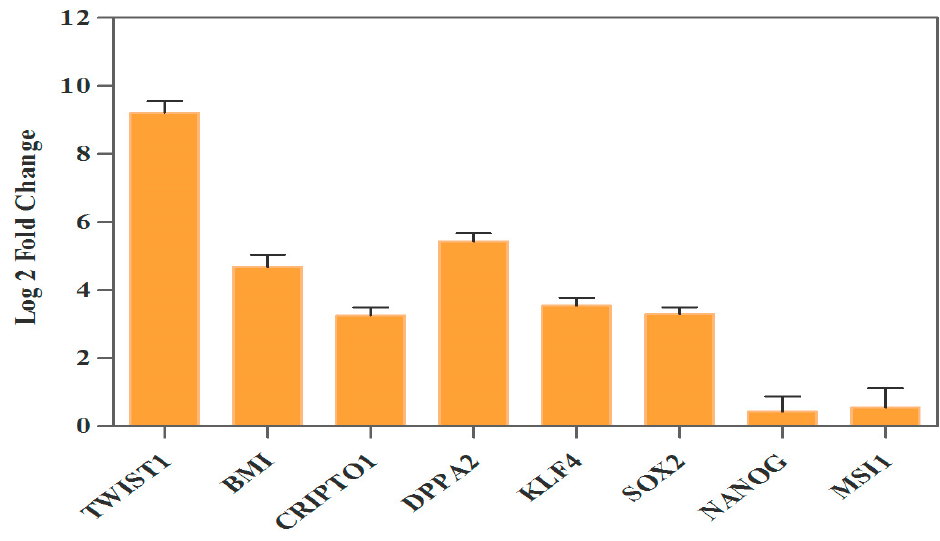
Figure 2. Ectopic expression of TWIST1 gene has a significant impact on cancer stem cell self-renewal genes’ expression in KYSE-30 cells. Retroviral transduction enforced significant TWIST1 overexpression in pruf-IRES-GFP-hTWIST1 by nearly 9-fold compared to GFP control cells, causing a 4.5-, 3.2-, 5.5-, 3.5-, and 3.7-fold increase in the mRNA level of BMI1 , CRIPTO1 , DPPA2 , KLF4 , and SOX2 . Forced expression of TWIST1 had no effect on the mRNA expression of NANOG and MSI1 genes.